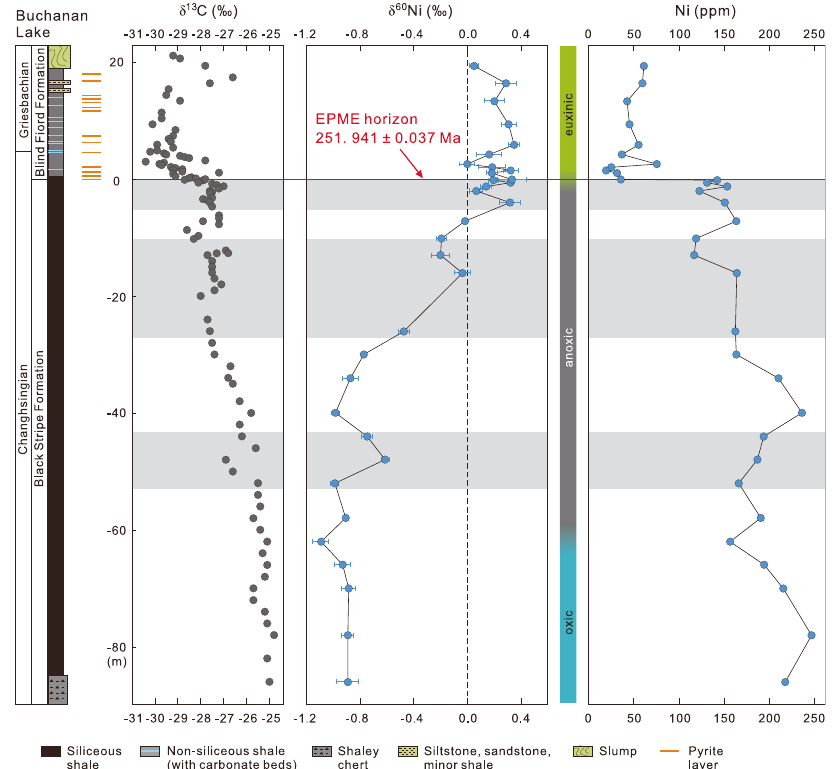
Fig. 2 Nickel isotopic compositions and Ni contents of black shales in the Buchanan Lake section. Error bars represent 2 s.d. The C-isotope chemostratigraphy is from ref. 5 and shaded areas refer to fl y coal ash loading events reported in ref. 5 . Palaeo-redox conditions are from refs. 21,22 and U-Pb age for the EPME horizon is from ref. 27